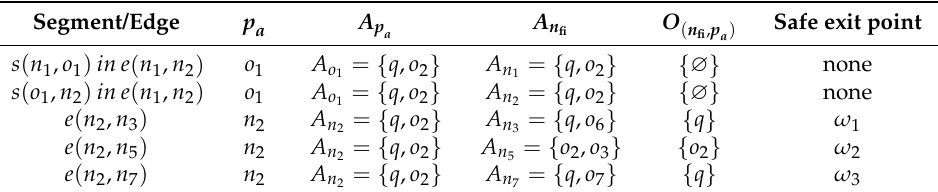
Table 4. Computation of safe exit points for o 1 .